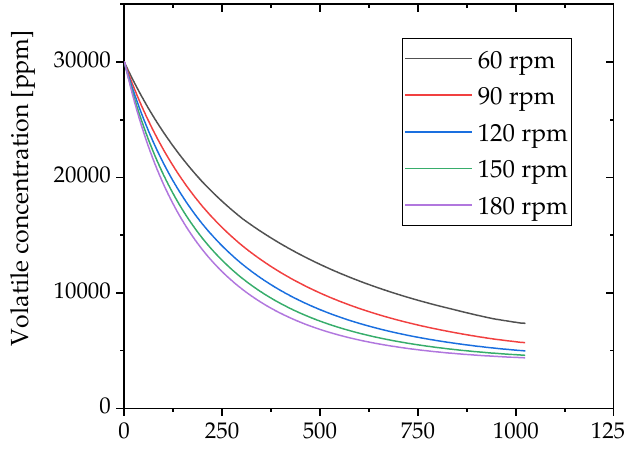
Figure 7. Simulation results of toluene concentration along the machine direction of twin-screw extruder.